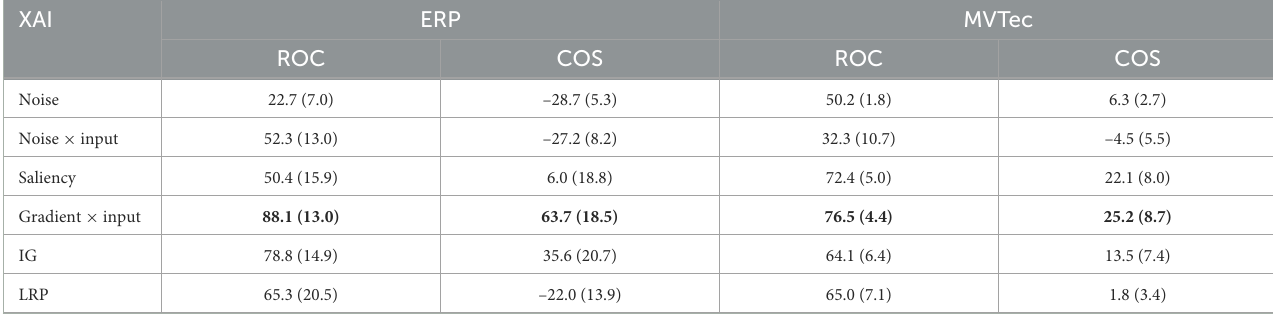
TABLE 3 Mean and standard deviation of gradient XAI performance comparing to ground truth explanations over all anomalies for ERP and MVTec data,